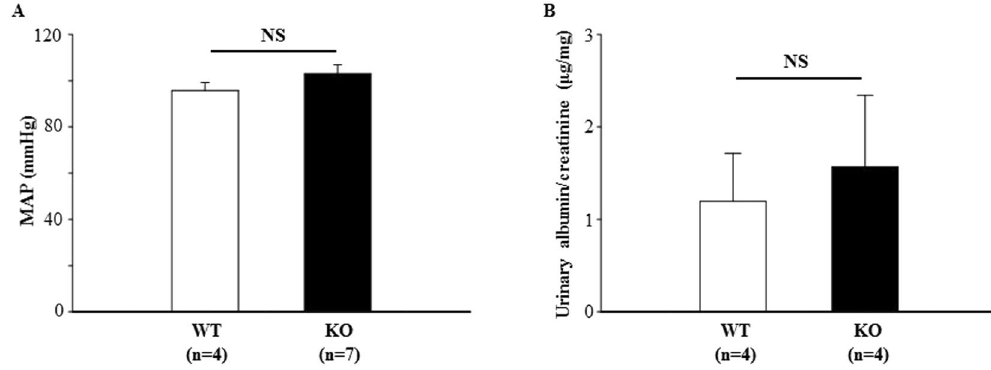
Figure 2. Influence of TRPC6 knockout on arterial blood pressure and urinary albumin excretion. ( A ) Mean arterial blood pressure (MAP) in WT and KO mice measured by radiotelemetry. ( B ) Urinary albumin excretion in WT and TRPC6 KO mice. NS indicates no significant difference, KO vs. WT. “n” indicates the number of mice in each group.